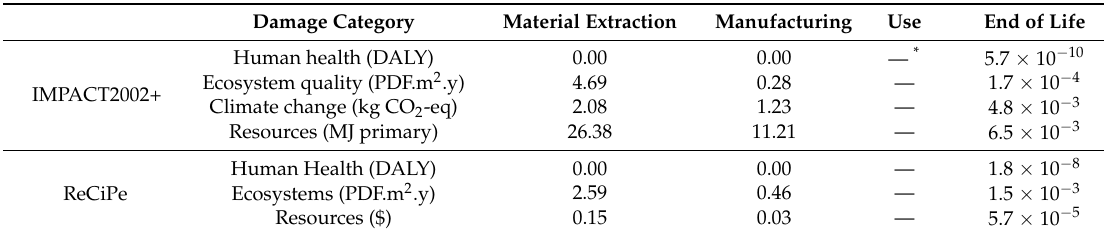
Table 4. Damage assessment results of a PCM panel (0.00153 m 3 ) for different life cycle stages based on two impact assessment methods.